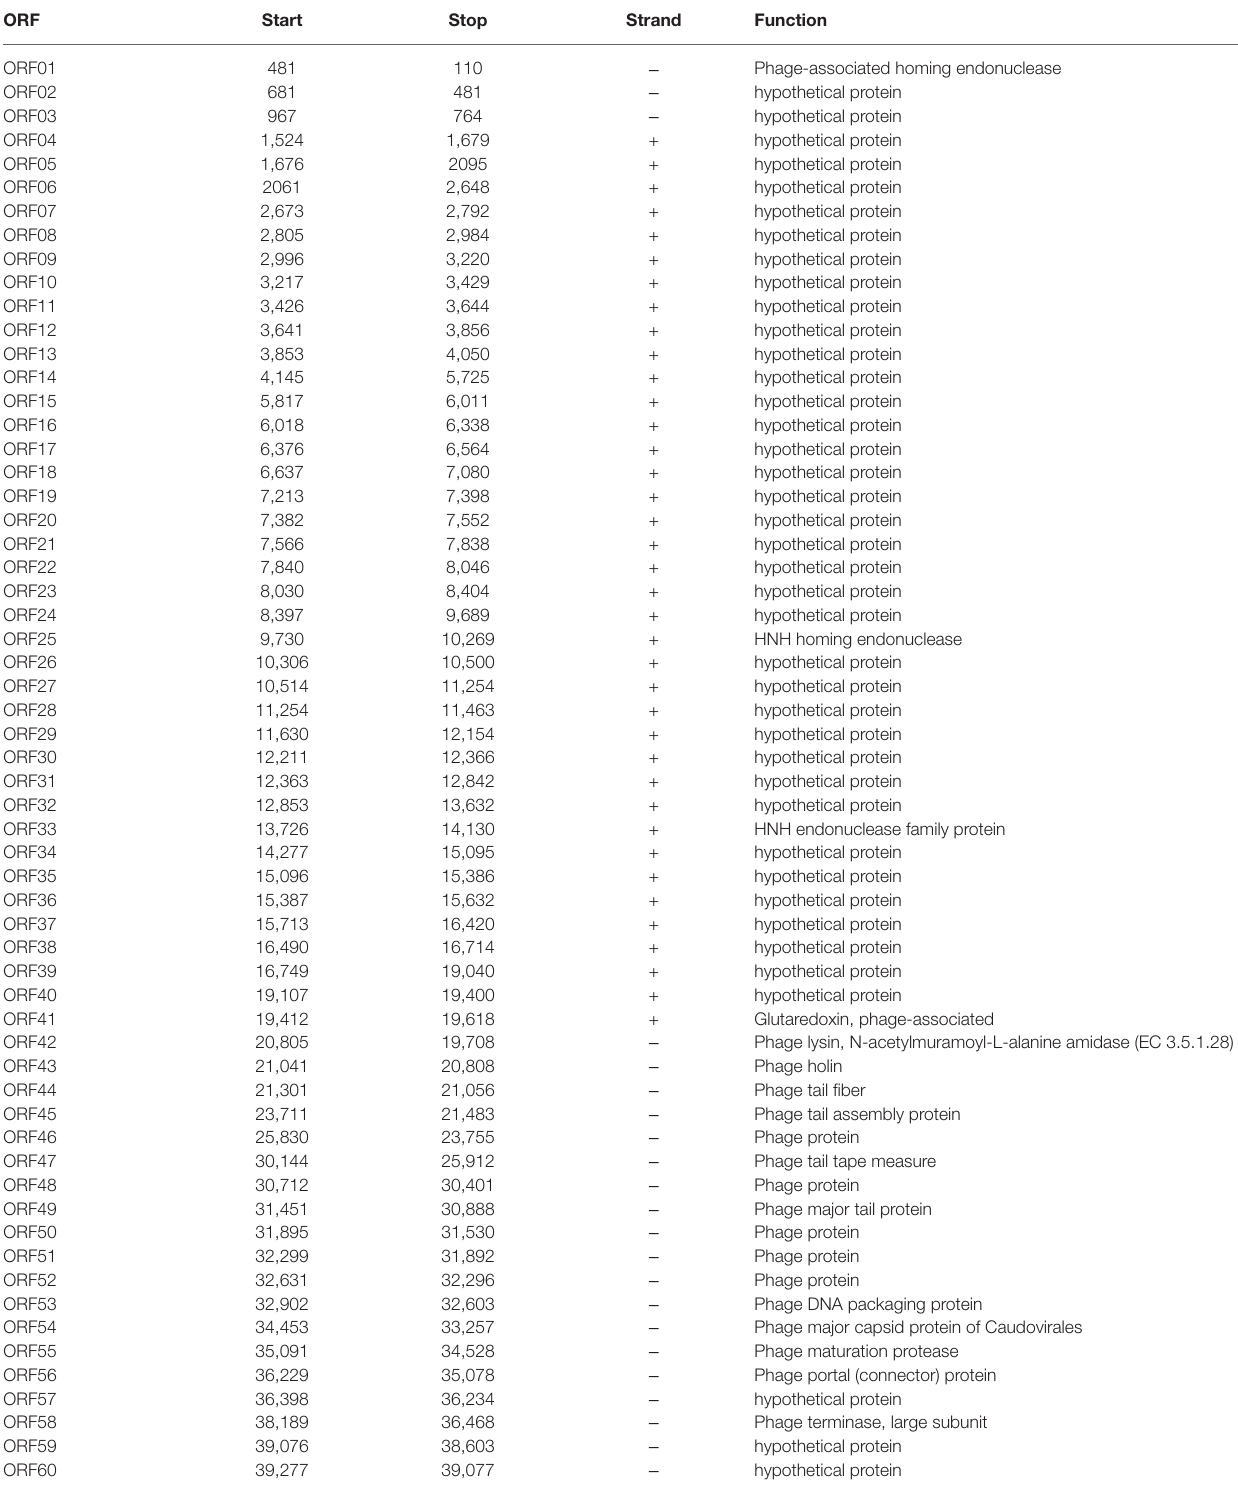
TABLE 3 | The ORFs of